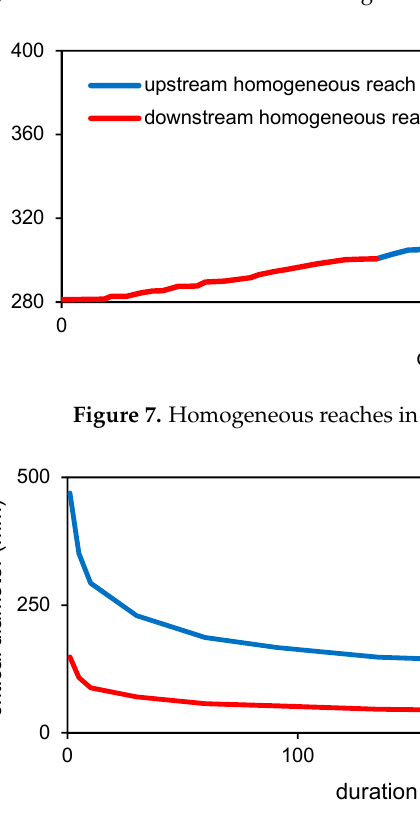
Figure 8. Duration curve of the critical diameter (averaged along homogeneous reaches).